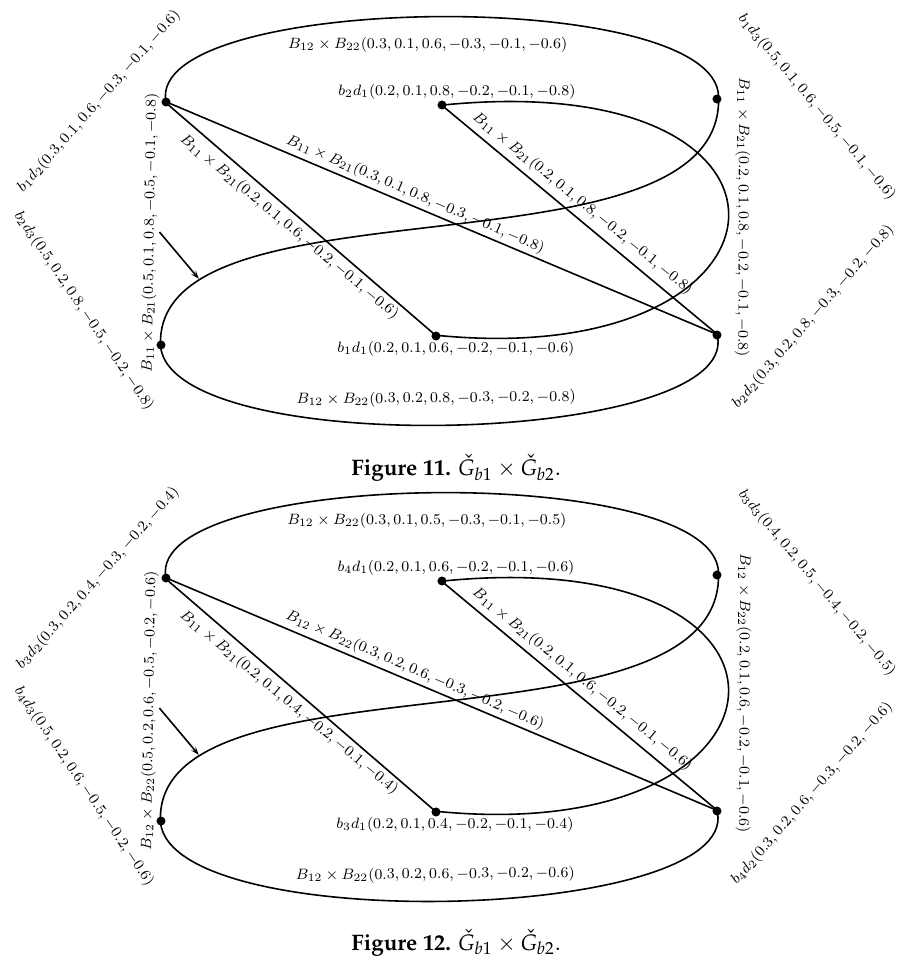
Figure 12. ˇ G b 1 × ˇ G b 2 Figure 2.12: ˇ G b 1 × ˇ G b 2